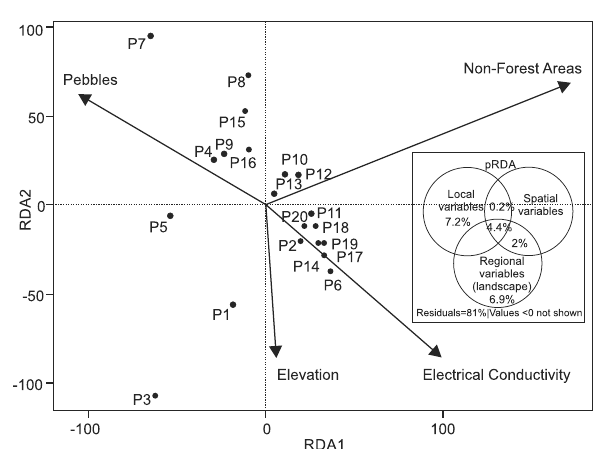
Figure 3. Partial redundancy analysis (pRDA) of the invertebrate communities based on the spatial and local and regional environ- mental matrices. Percentages of explained variation are shown in the inset Venn diagram.